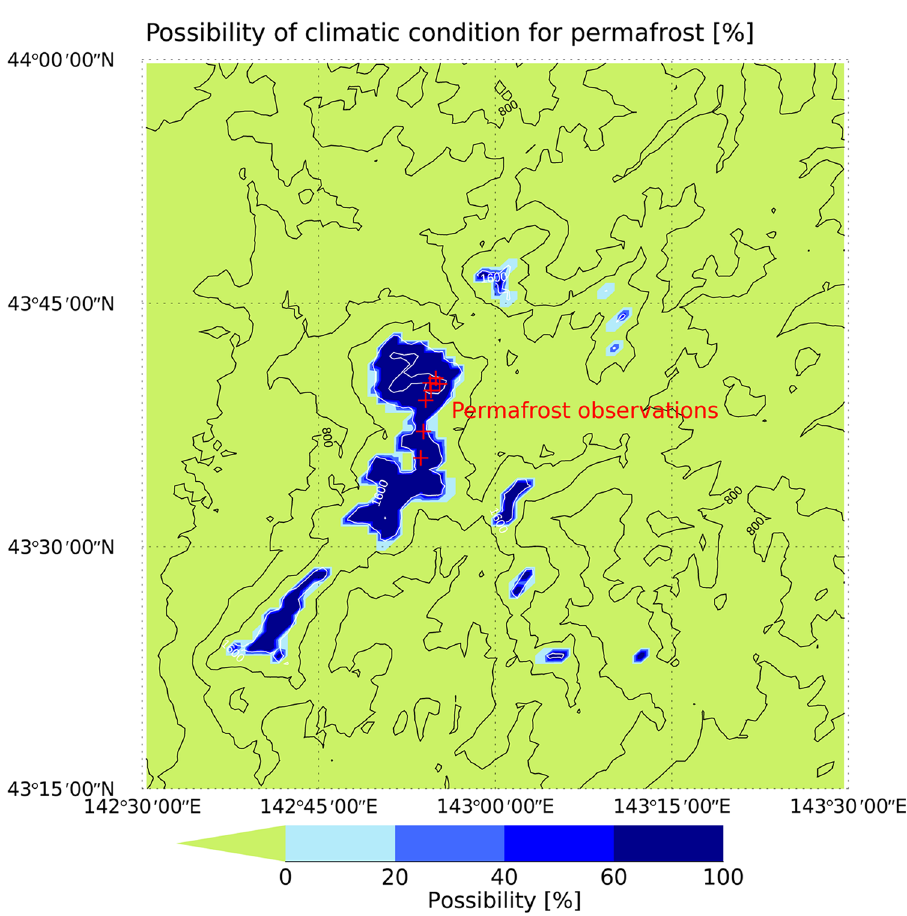
Figure 2. Location of climatic conditions favoring the development and maintenance of permafrost in the Daisetsu Mountains in 2010 under current climate conditions [%]. Contour lines show altitude distribution. The environmentally conditioned permafrost (ECP) region is derived based on the probability determined based on the four bias-corrected climate scenarios. Red points indicate the places where permafrost has been observed (see Supplementary Table S1). IDL (https:// www. l3har risge ospat ial. com/ Softw are- Techn ology/ IDL) is used to plot this